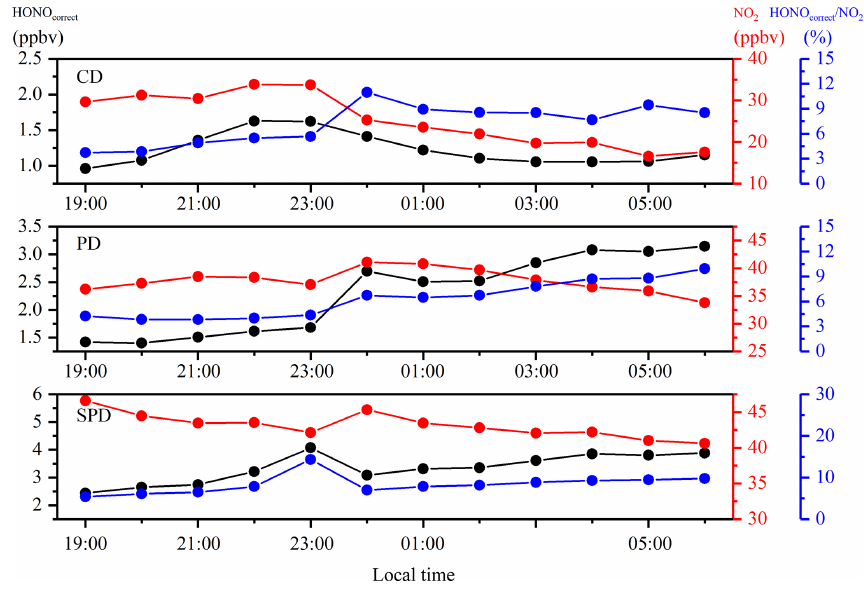
Figure 8. Nocturnal variations of HONO correct , NO 2 , and HONO correct / NO 2 in CD, PD, and SPD periods.